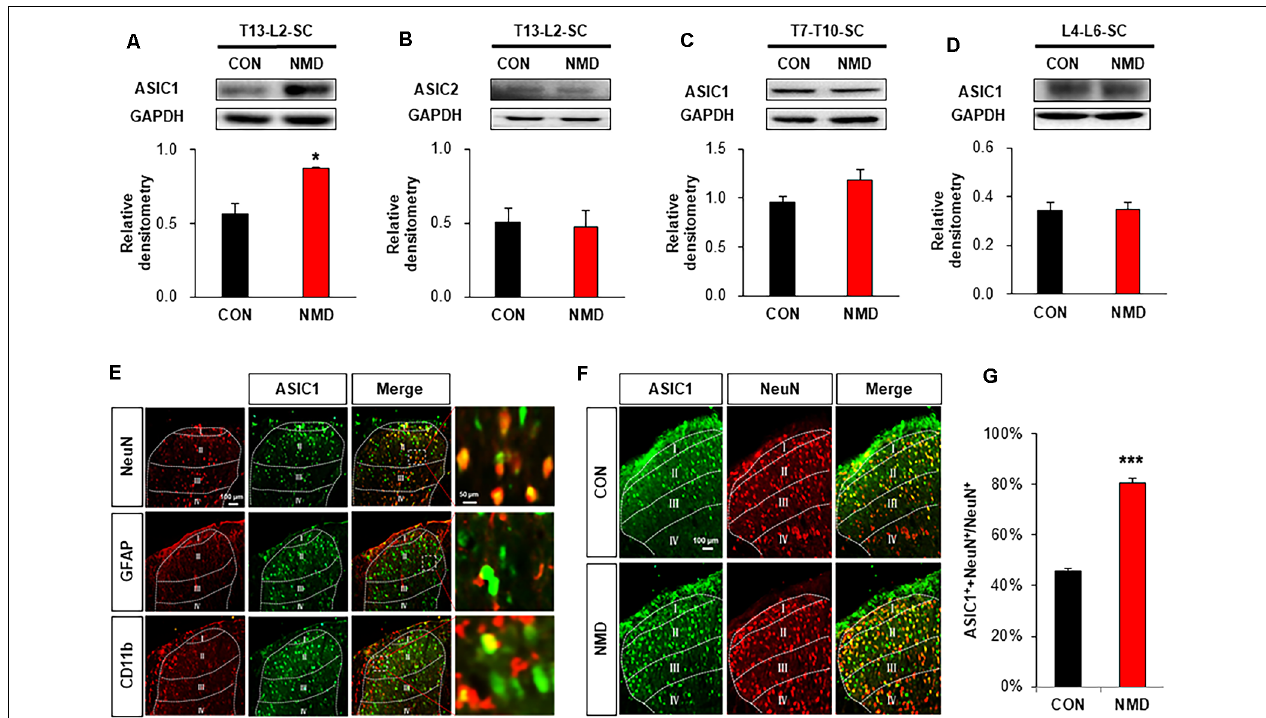
FIGURE 3 | NMD enhanced acid-sensing ion channel 1 (ASIC1) expression. (A) Expression of ASIC1 in the spinal dorsal horn of T13-L2 in NMD rats compared with CON rats (* P < 0.05, n = 5 rats for CON and n = 4 rats for NMD, two-sample t -test). (B) Expression of ASIC2 in the spinal dorsal horn of T13-L2 in NMD rats compared with CON rats ( P > 0.05, n = 5 rats for CON and n = 4 rats for NMD, two-sample t -test). (C) Expression of ASIC1 in the spinal dorsal horn of T7–T10 in NMD rats compared with CON rats ( P > 0.05, n = 4 rats for each group, two-sample t -test). (D) Expression of ASIC1 in the spinal dorsal horn of L4–L6 in NMD rats compared with CON rats ( P > 0.05, n = 4 rats for each group, two-sample t -test). (E) Location of ASIC1 in the spinal dorsal horn of T13-L2 in NMD rats. (F) Co-localization of ASIC1 and NeuN in the spinal dorsal horn of T13-L2 in CON and NMD rats. (G) Expression of ASIC1 in the spinal dorsal horn of T13-L2 in CON and NMD rats (*** P < 0.001, n = 3 rats for each group, two-sample t